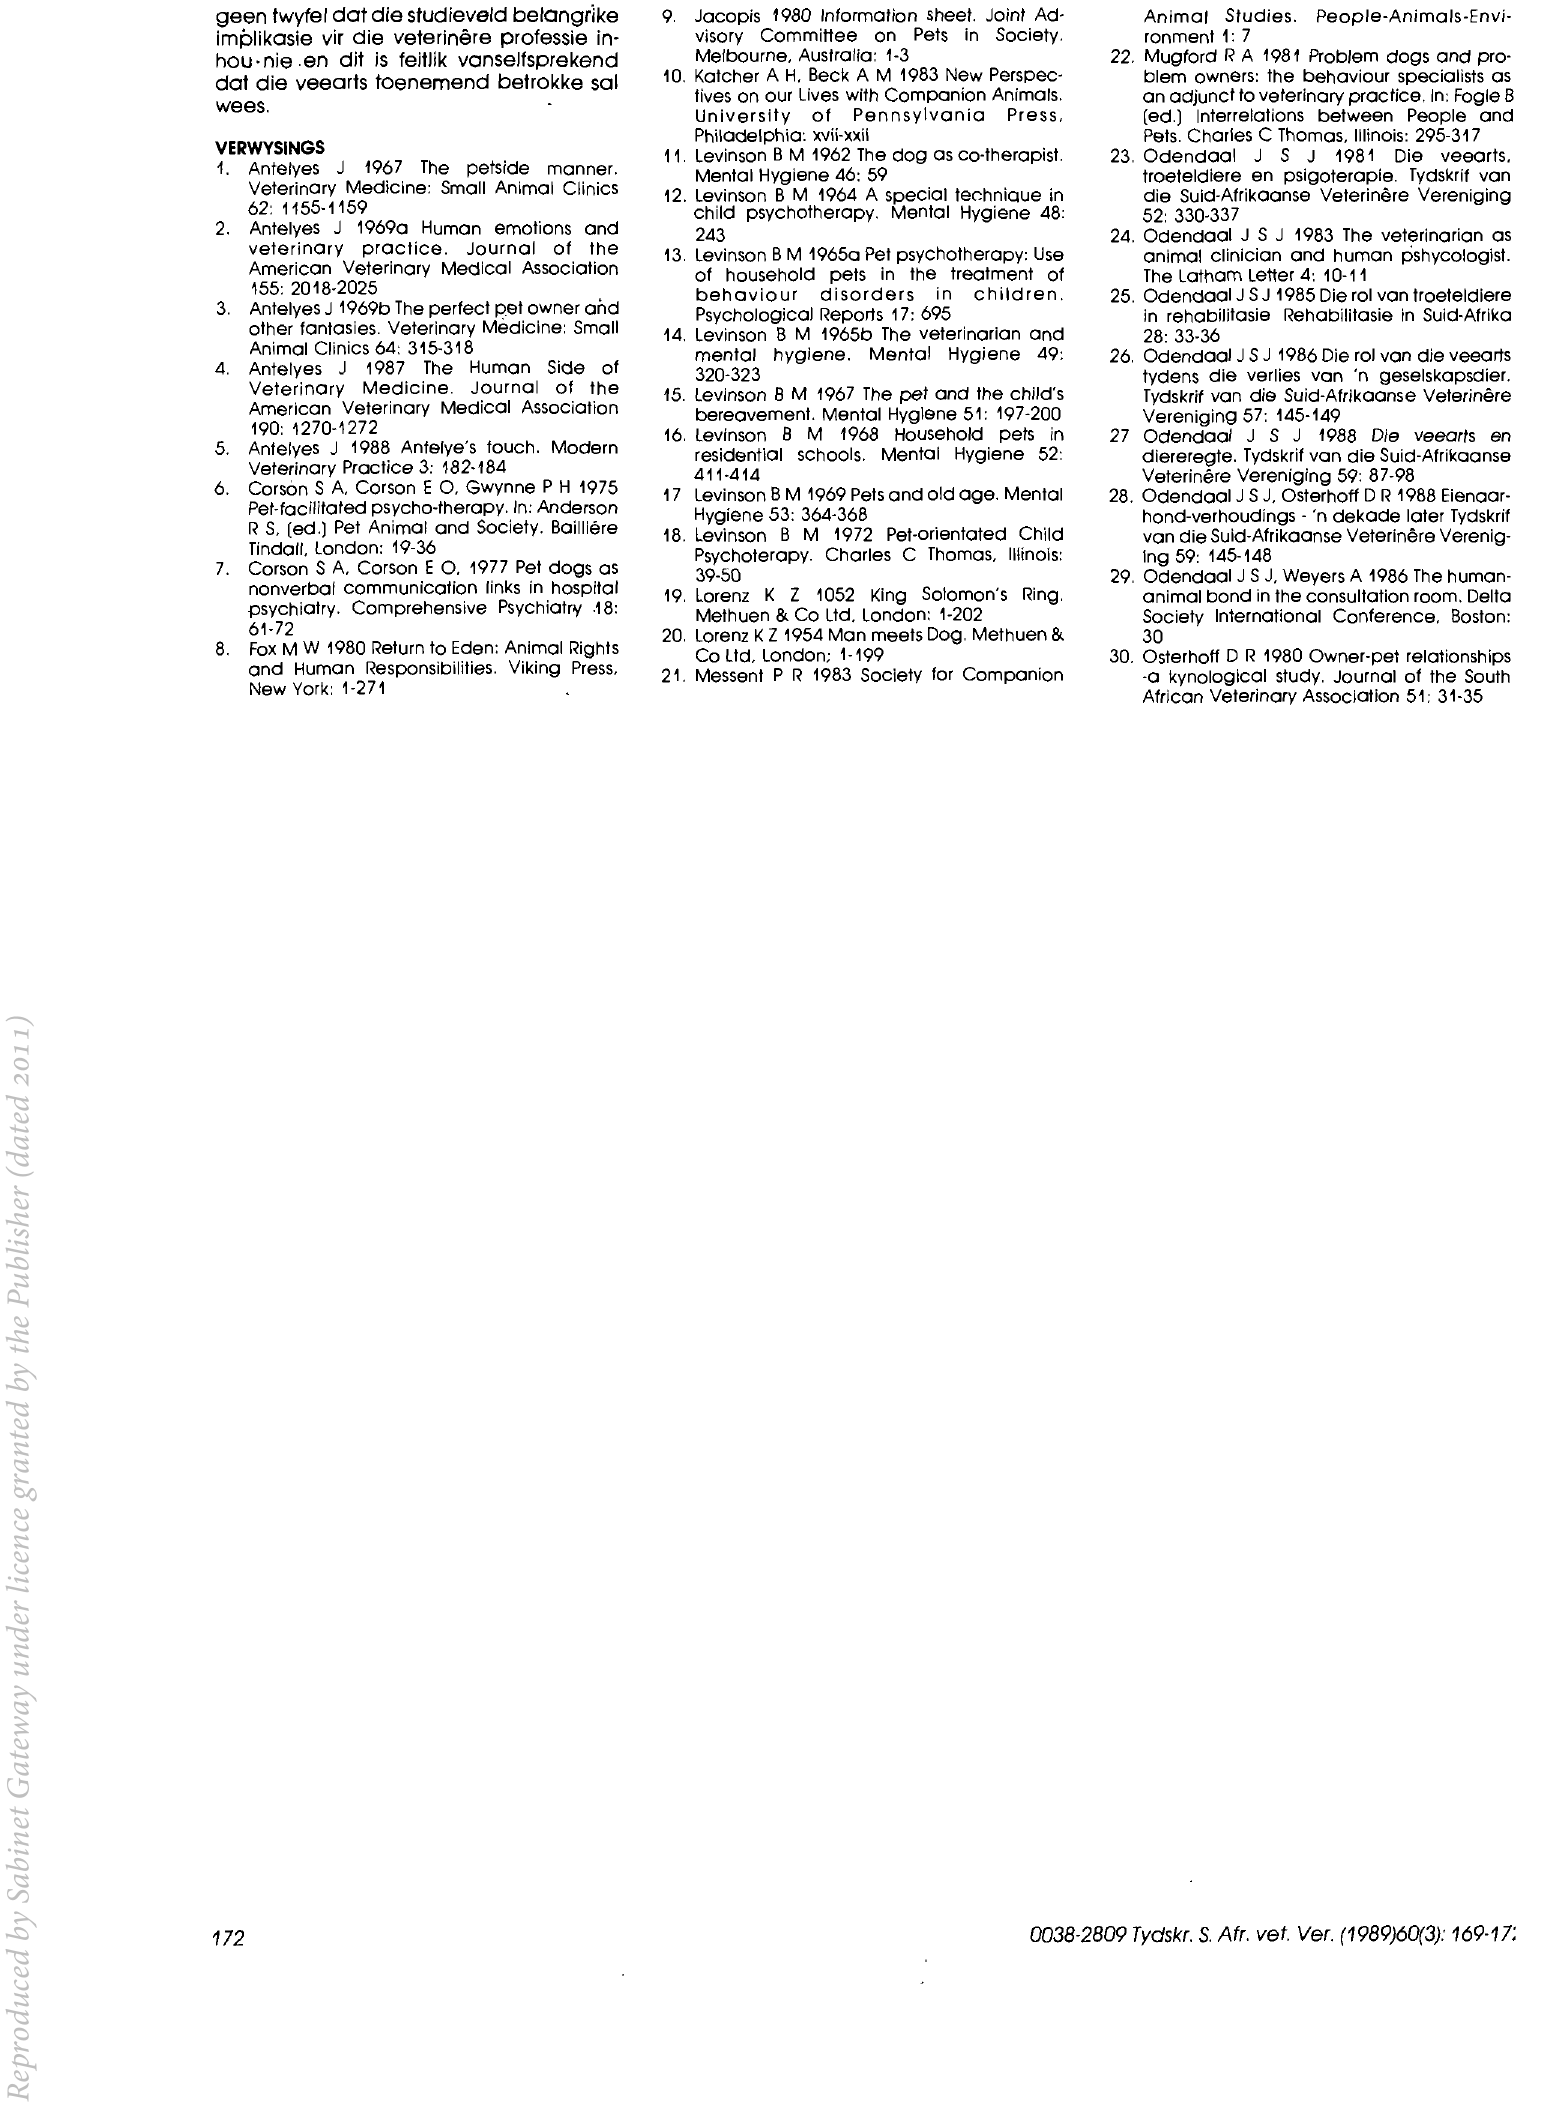
geen twyfel dot die studieveld belongrike implikosie vir die veterinere professie in hou· nie en dit is feitlik vonselfsprekend dot die vee arts toenemend betrokke sal